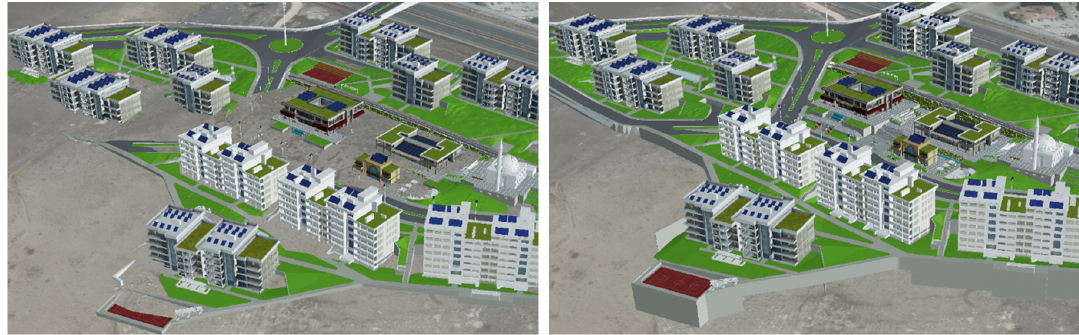
Figure 14. The planned city model with the original ( left ) and pre-processed ( right ) DTM.